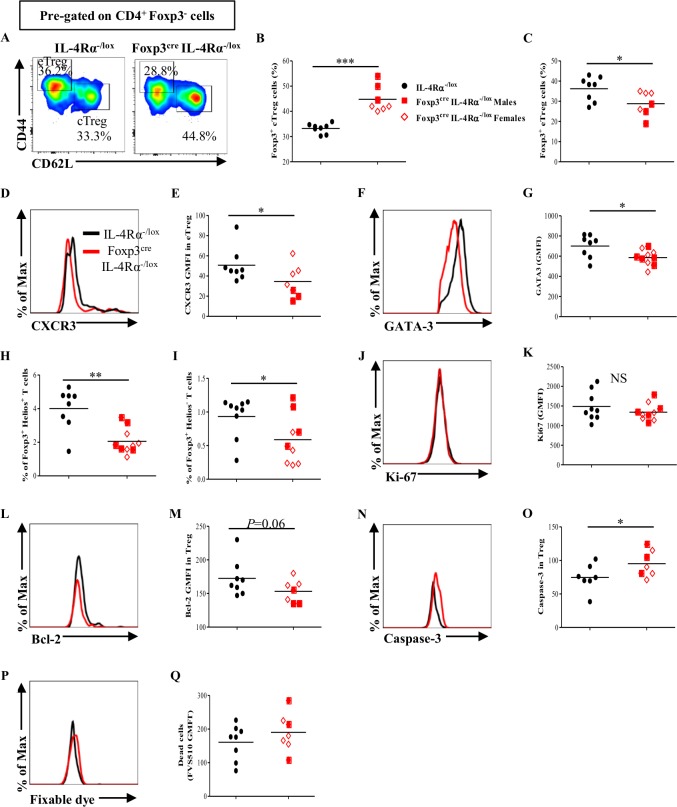
IL-4Rα-mediated signaling on Foxp3+ Treg cell is required for eTreg cell expansion, recruitment, and sustainability during schistosomiasis.(A) Representative flow cytometry of cTreg cells and eTreg cells from the hLN of mice infected with Sm for 8 wk. (B) Frequency of central CD4+ Foxp3+ Treg cells (left) and (C) effector CD4+ Foxp3+ Treg cells from (A). (D) Representative histogram of CXCR3 expression by effector CD4+ Foxp3+ T cells in the hLN 8 wk post infection with the mean values summarized in (E). (F) Representative histogram of GATA3 expression by CD4+ Foxp3+ T cells in the liver 8 wk post infection with the mean values summarized in (G). (H) Frequency of CD4+ Foxp3+ Helios+ Treg cells in the liver of Sm-infected mice. (I) Frequency of CD4+ Foxp3+ Helios− Treg cells in the liver of Sm-infected mice. (J) Representative histogram of Ki-67 expression by CD4+ Foxp3+ T cells in the liver 8 wk post infection with the mean values summarized in (K). (L) Representative histogram of Bcl-2 expression by CD4+ Foxp3+ T cells in the liver 8 wk post infection with the mean values summarized in (M). (N) Representative histogram of caspase-3 expression by CD4+ Foxp3+ T cells in the liver 8 wk post infection with the mean values summarized in (O). (P) Representative histogram of fixable dye in CD4+ Foxp3+ T cells in the liver 8 wk post infection with the mean values summarized in (Q). Results pooled from two independent experiments with 3–4 mice/group. Data are expressed as mean ± S.E.M. NS, P > 0.05; * P < 0.05, ** P < 0.001, *** P < 0.0001 by two-tailed unpaired Student t test. Underlying data can be found in S1 Data. Bcl-2, B cell lymphoma 2; CD44, cluster of differentiation 44; CD62L, L-selectin; cTreg, central regulatory T; CXCR3, C-X-C motif chemokine receptor 3; eTreg, effector regulatory T; Foxp3, forkhead box P3; GATA3, GATA binding protein 3; GMFI, geometric mean fluorescence intensity; hLN, hepatic lymph node; IL-4Rα, interleukin-4 receptor alpha; NS, not significant; Sm, S. mansoni; Treg, regulatory T.